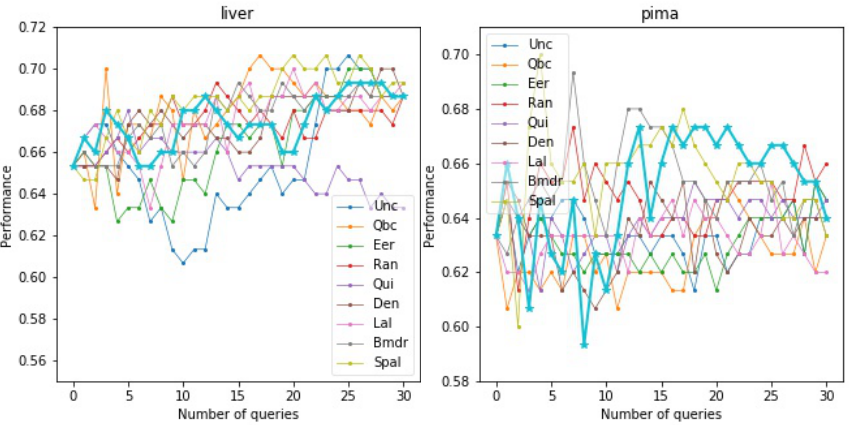
Figure 2. Performance on different datasets with query size = 30; it can be seen that, in the case of a single query, although the start is relatively slow, it can quickly improve in most data sets. In addition, it performs better than most data sets. These situations show that active learning with Bhattacharyya distance as a measure is superior in comparison with the same type of active learning. However, there are still relatively unstable situations in some data sets, indicating that the algorithm may need further optimization in specific occasions.